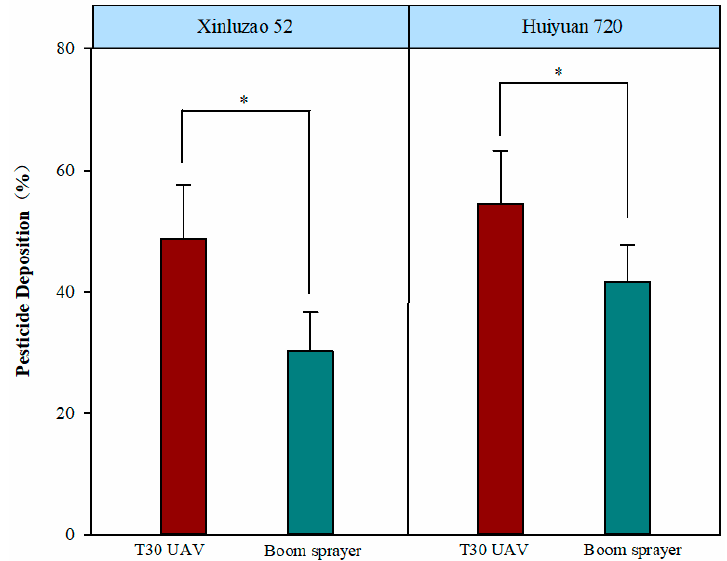
Figure 4. Effects on pesticide utilization rate. Note: * represents a significant difference compared with the other treatment ( p < 0.05).